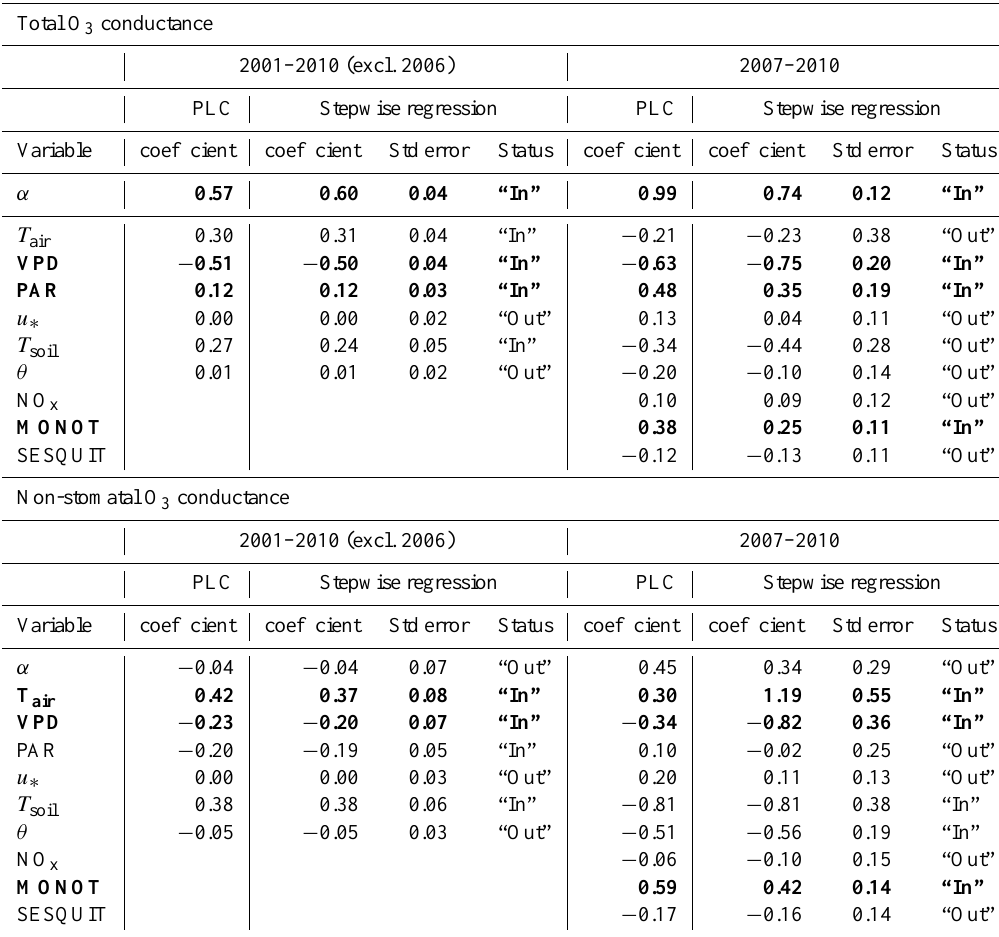
Table 2. Multivariate regression coefficients and statistics relating daily average environmental variables and concentrations to the total O 3 day-time conductance (upper table) and the non-stomatal O 3 day-time conductance (lower table). PLC refers to the Partial Least Squares method of multivariate analysis. The models were applied to dimensionless data by performing centering and scaling with standard deviation of the time series. The photosynthetic capacity variable α , air temperature T air , vapor pressure deficit VPD, photosynthetically active radiation PAR, friction velocity u ∗ , soil temperature T soil , volumetric soil water content θ , and ambient air concentrations of NO x , monoterpenes (MONOT) and sesquiterpenes (SESQUIT) were used as explaining variables. The status “In” denotes variables that we included in the final model by the Stepwise regression method. Bold lines denote significant explaining